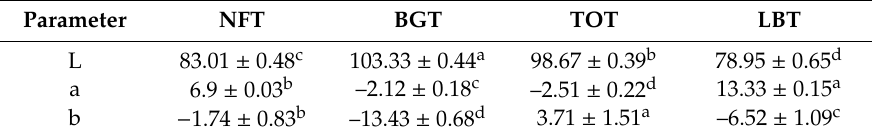
Table 6. Color values of di ff erent tea